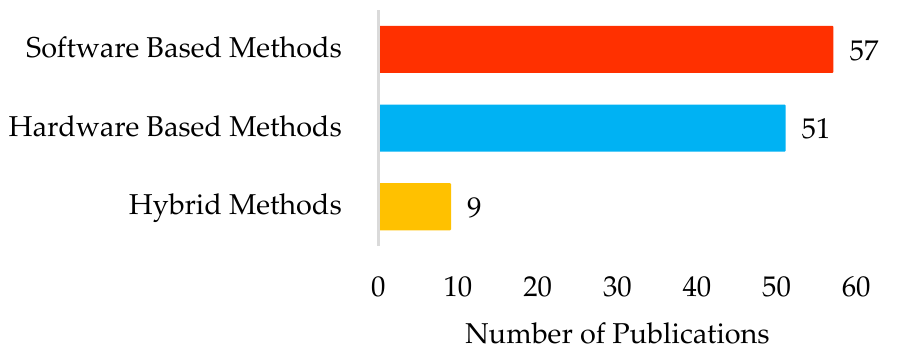
Figure 14. Subdivision of FRT articles in PMSG-based wind turbines.